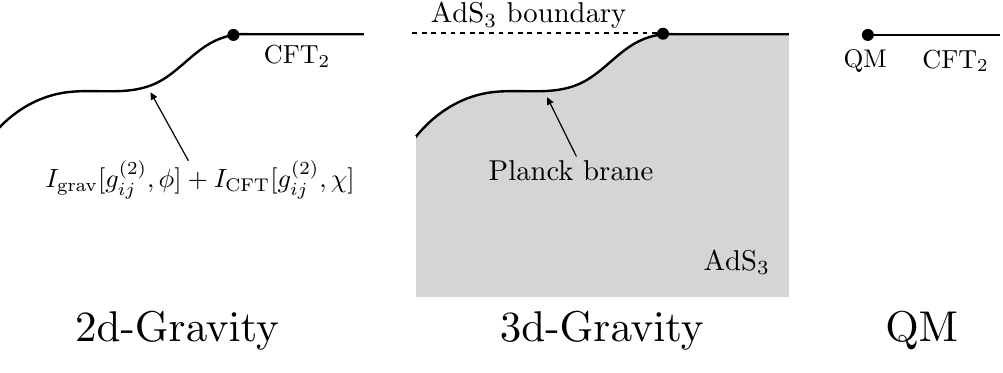
Figure 2 . We sketch three di(cid:11)erent pictures of the same system. The (cid:12)rst is a 2d dilaton-gravity theory, plus a matter CFT 2 , coupled to a bath consisting of the same CFT 2 . This CFT 2 is assumed to have a holographic dual. The second is 3d gravity, where we replace the CFT 2 by its holographic dual. It contains a dynamical boundary metric on the Planck brane. More details about the state of the CFT are encoded deeper inside the 3d geometry. The third is the fully quantum mechanical description, where we replace the 2d gravity+matter theory by its quantum mechanical dual. This quantum mechanical system lives at the boundary of the bath CFT. In all cases, the thick dot represents the point (cid:27) y =